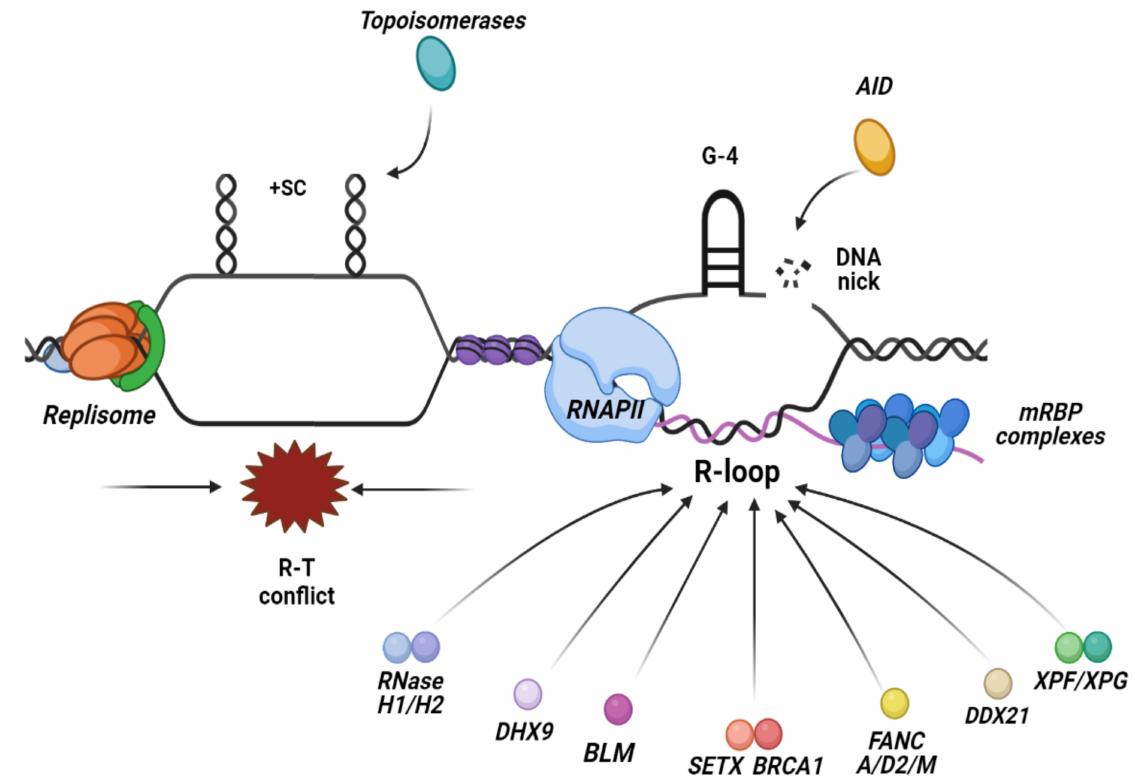
Figure 2. R-loops are formed at the site of collisions between the replisome and RNAPII when they move along the DNA in opposite directions, leading to a head-on conflict between the two machineries. The main preventative mechanisms that inhibit R-loops accumulation are the regulation of torsional stress via the topoisomerases activity that relaxes supercoiled DNA in the vicinity of the forks and the transcript regulation, ensuring the proper packaging and processing of the mRNA. Factors implicated in the resolution of R-loops include nucleases such as, RNase H1/2 enzymes that hydrolyze the RNA moiety of the RNA:DNA hybrid and TC-NER factors, and a plethora of RNA/DNA helicases that unwind the